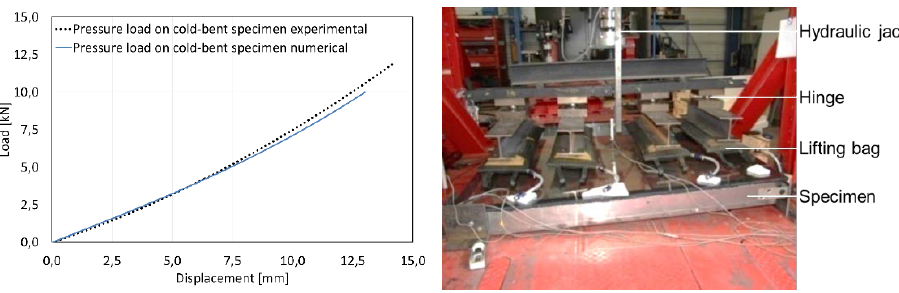
Fig. 9 Comparison experimental data and simulation for a cold-bent hybrid cell under pressure load (left), test setup